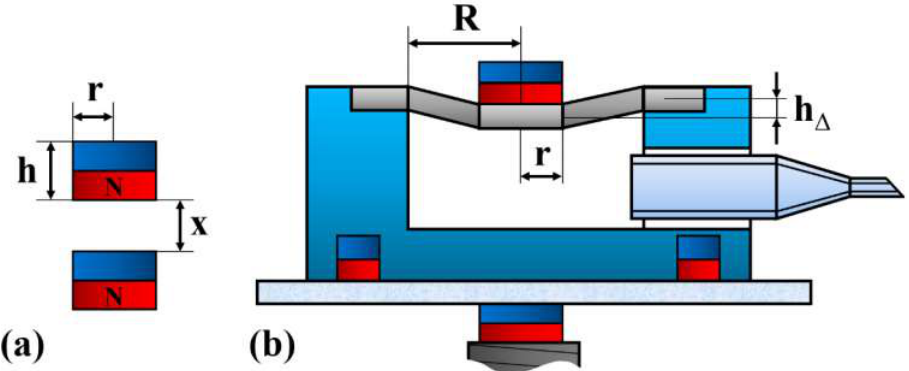
Figure 5. Diagram of employed permanent magnets and millirobot pedestal. ( a ) Parameters to determine the magnetic force between two cylindrical permanent magnets, ( b ) parameters to determine the hollow volume variation.